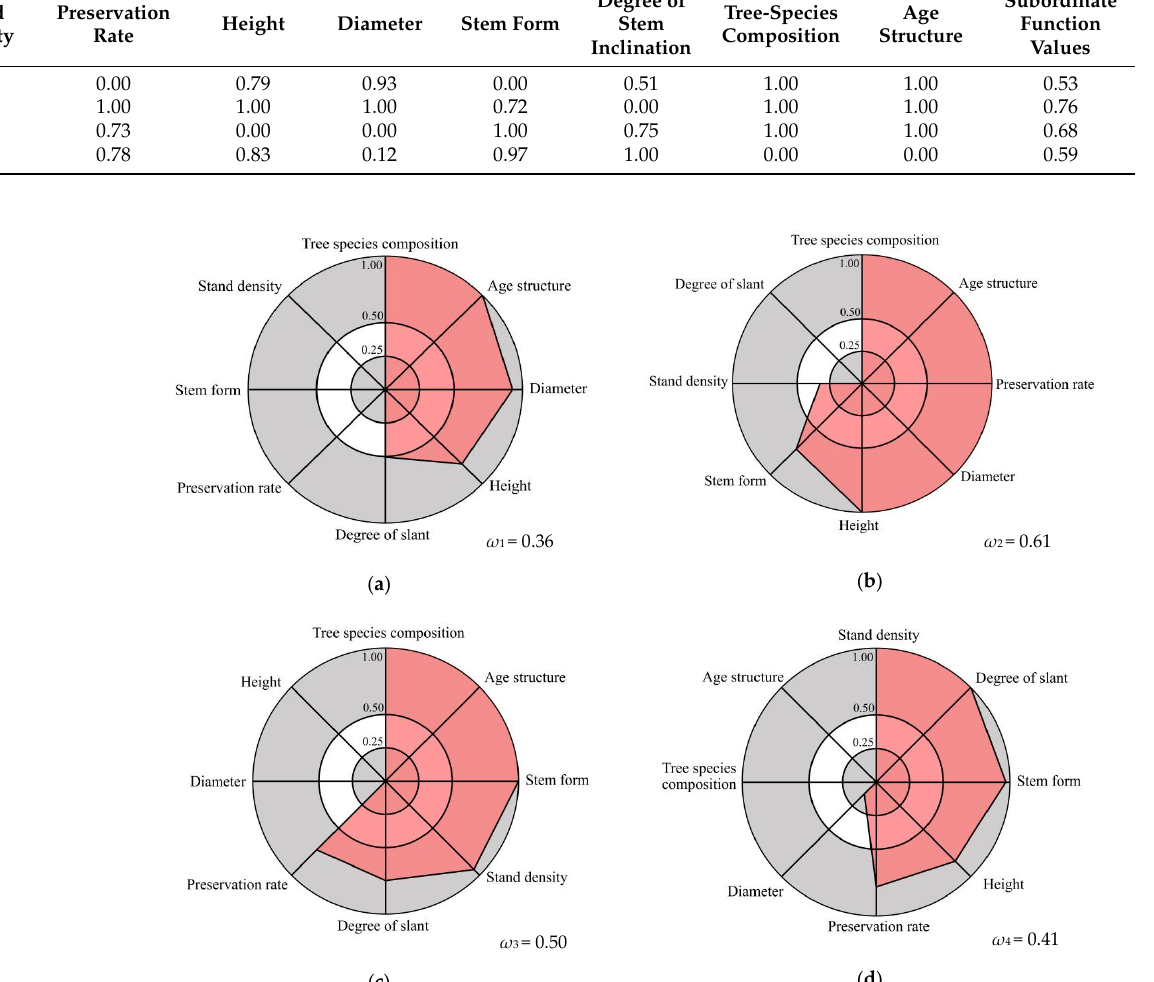
Table 9. Subordinate function values of eight nonspatial structure indexes and their means of stands. Stand Stand Type Density